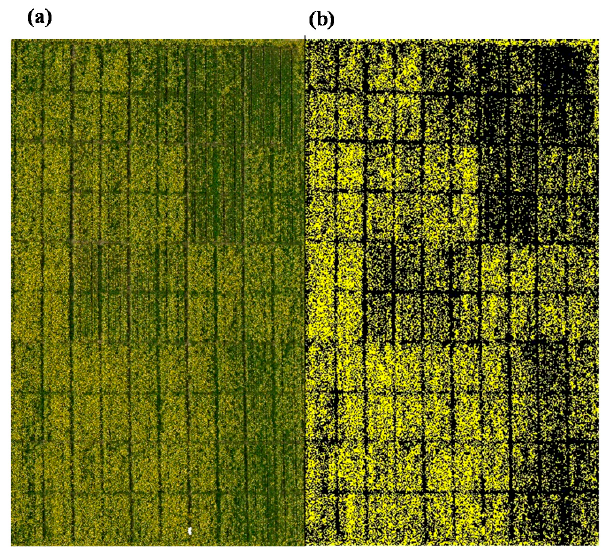
Figure 5. An example of image classification result of rape fields at Zhuji on 28 March 2018. ( a ) The original image of oilseed rape field and ( b ) the result of image classification using K-means method based on Commission Internationale de l’Éclairage (CIE) L*a*b* space were presented.